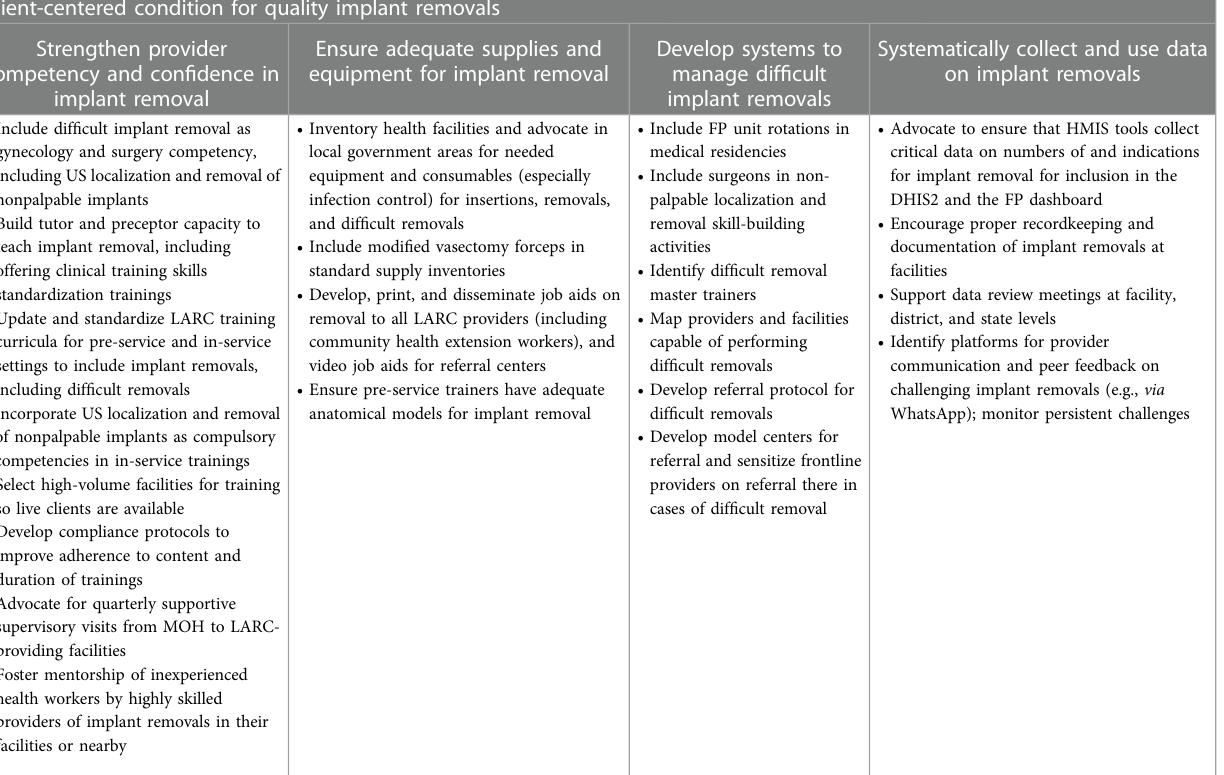
TABLE 6 Roadmap to providing quality implant removal services. Client-centered condition for quality implant